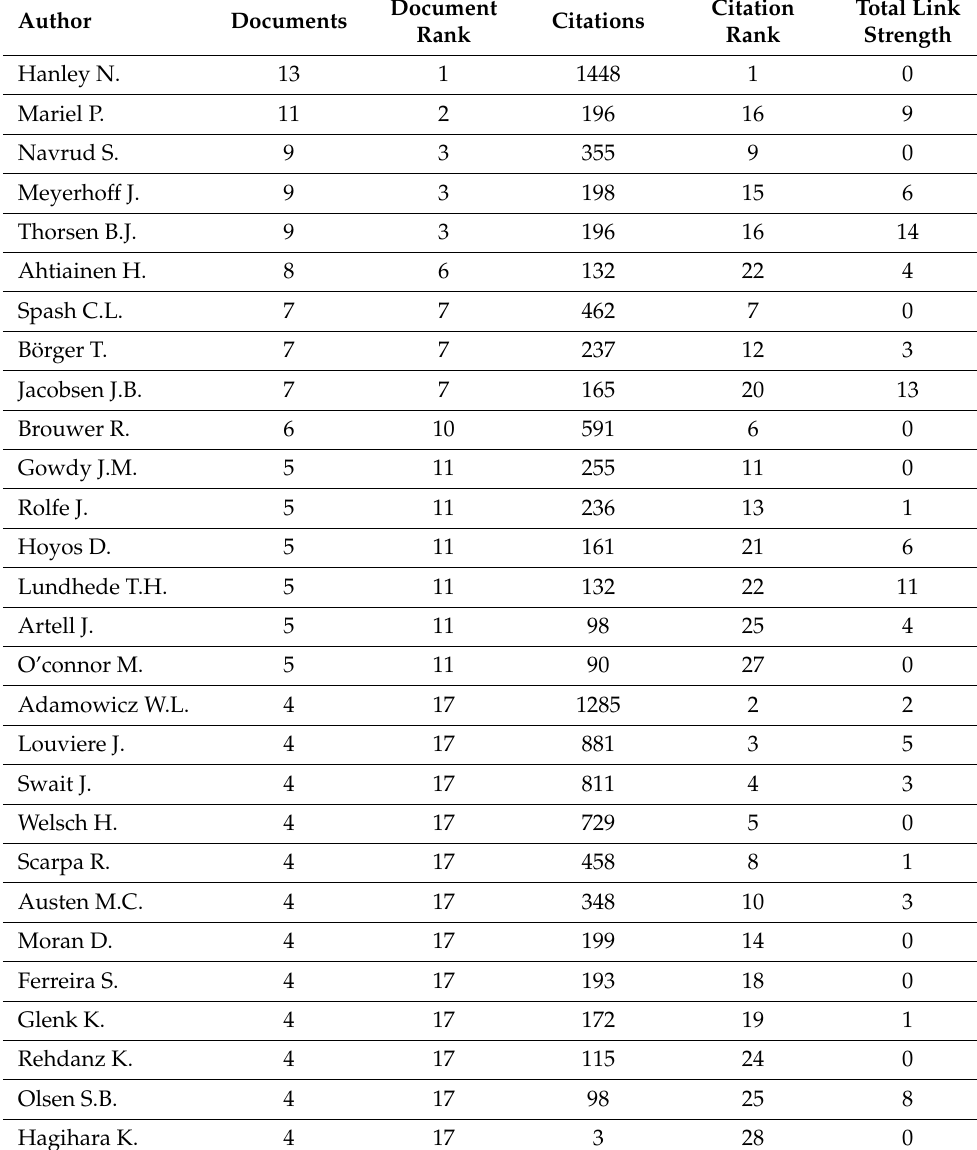
Table 4. Publication by authors and citation